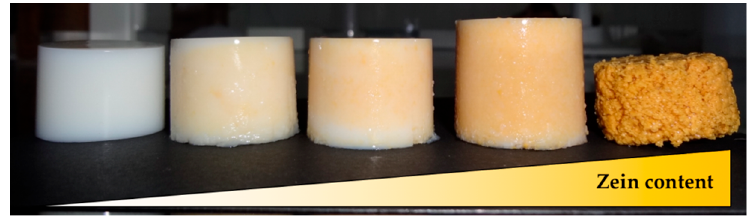
Figure 1. Appearance of starch-zein gels obtained from aqueous solutions with 10 wt.% starch and increasing zein content (from left to right, 0:1, 1:5, 1:3, 1:1, and 1:0 zein-to-starch weight ratio).